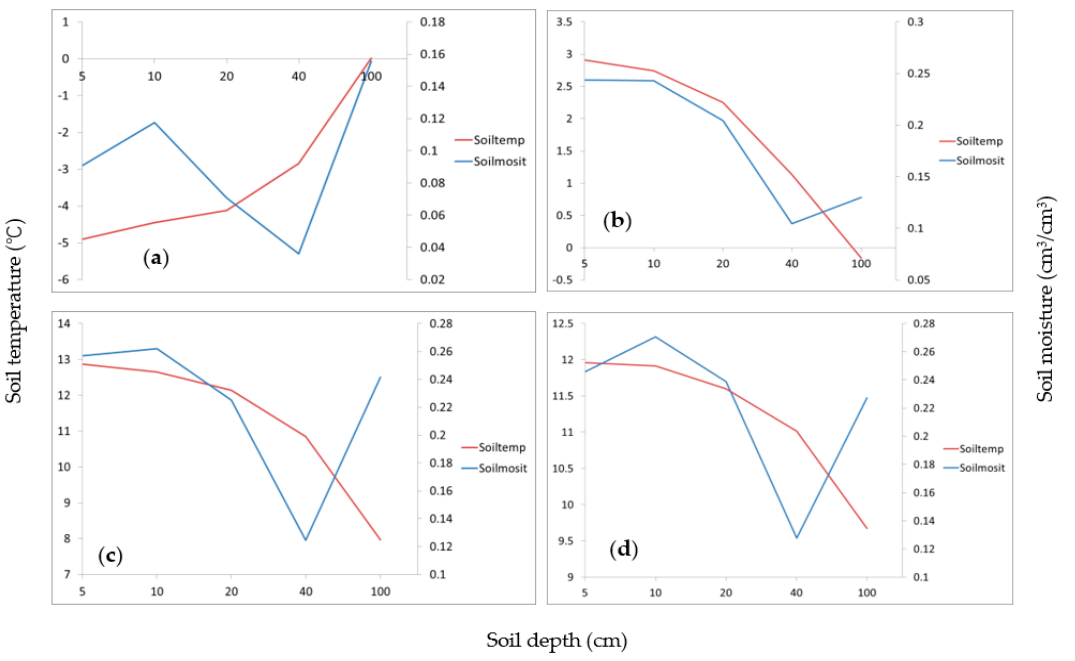
Figure 11. Same as Figure 9, but for the Biru station. ( a ) Winter. ( b ) Spring. ( c ) Summer. ( d ) Autumn.